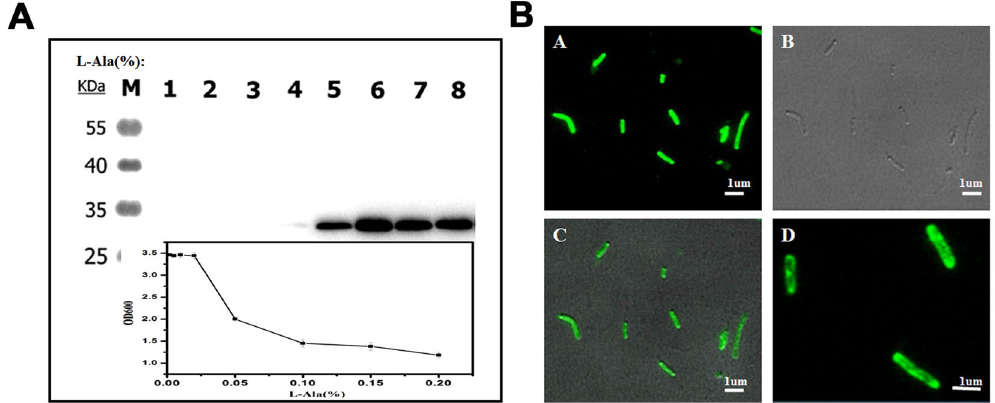
Figure 4. Overexpression optimization and Fluorescence images of CsgG in BL21 (DE3) ∆ csgBAC . ( A ): Overexpression optimization of CsgG; as shown in the lower part of the chart, cell growth was dramatically inhibited by increasing concentrations of L-Ala. Hence, an optimization experiment for CsgG overexpression was conducted. Blots were probed with anti-His. Lanes 1 to 8 represent induction with the following concentrations of L-Ala (w/v): 0, 0.002, 0.005, 0.01, 0.02, 0.05, 0.1, and 0.15 (%). A concentration of 0.05% L-Ala was found to be optimal to facilitate CsgG expression while allowing cell growth. ( B ): Fluorescence images of CsgG in BL21 (DE3) ∆ csgBAC ; Cells containing CsgG-GFP fusions overexpressed in BL21 (DE3) ∆ csgBAC at 37 °C. Images show cells examined after the induction of fusion protein synthesis for 3 h. The fluorescent and bright image are shown individually in a and b; c indicates the merge image of a and b; the partial magnification of a is shown in d. The scale bars represent 1 µ m.